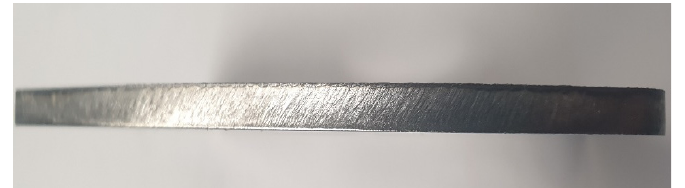
Figure A5. Edge surface quality of 4 mm mild steel workpiece cut with Nitrogen.